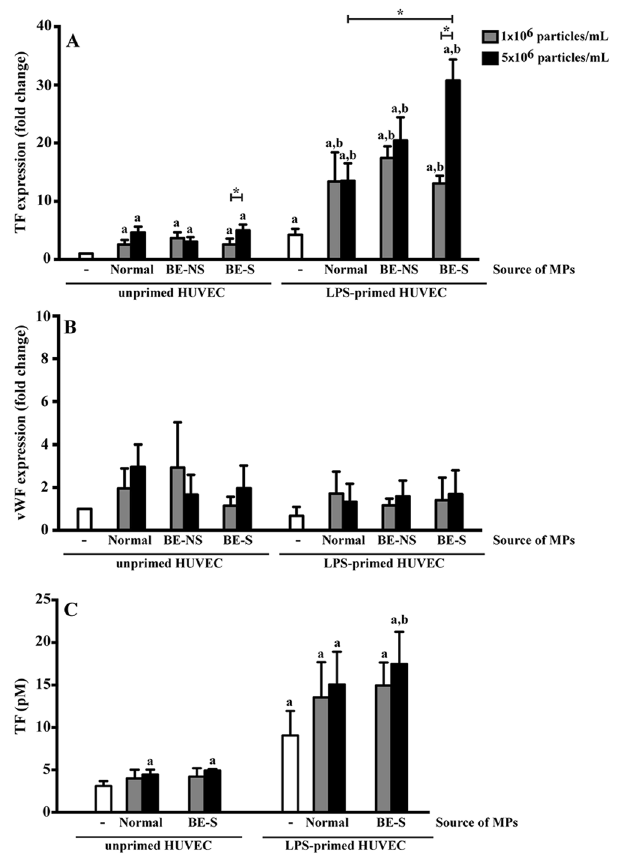
Figure 2. MPs induced coagulation protein expression. Unprimed and LPS-primed HUVECs were treated with 1 × 10 6 and 5 × 10 6 particles/mL MPs obtained from 7 normal subjects, 9 non-splenectomised β -thalassaemia/ HbE patients (BE-NS) and 9 splenectomised β -thalassaemia/HbE patients (BE-S). The expression of ( A ) tissue factor (TF) and ( B ) von Willebrand factor (vWF) were determined by RT-qPCR. ( C ) TF activity in supernatant secreted by HUVECs. Unprimed and LPS-primed HUVECs were treated with 1 × 10 6 and 5 × 10 6 particles/mL MPs obtained from 3 normal subjects and 3 splenectomised β -thalassaemia/HbE patients (BE-S). a Statistically significant difference when compared with unprimed HUVECs at P < 0.05. b Statistically significant difference when compared with LPS-primed HUVECs at P < 0.05. * Statistically significant difference between groups at P < 0.05. Each experiment was